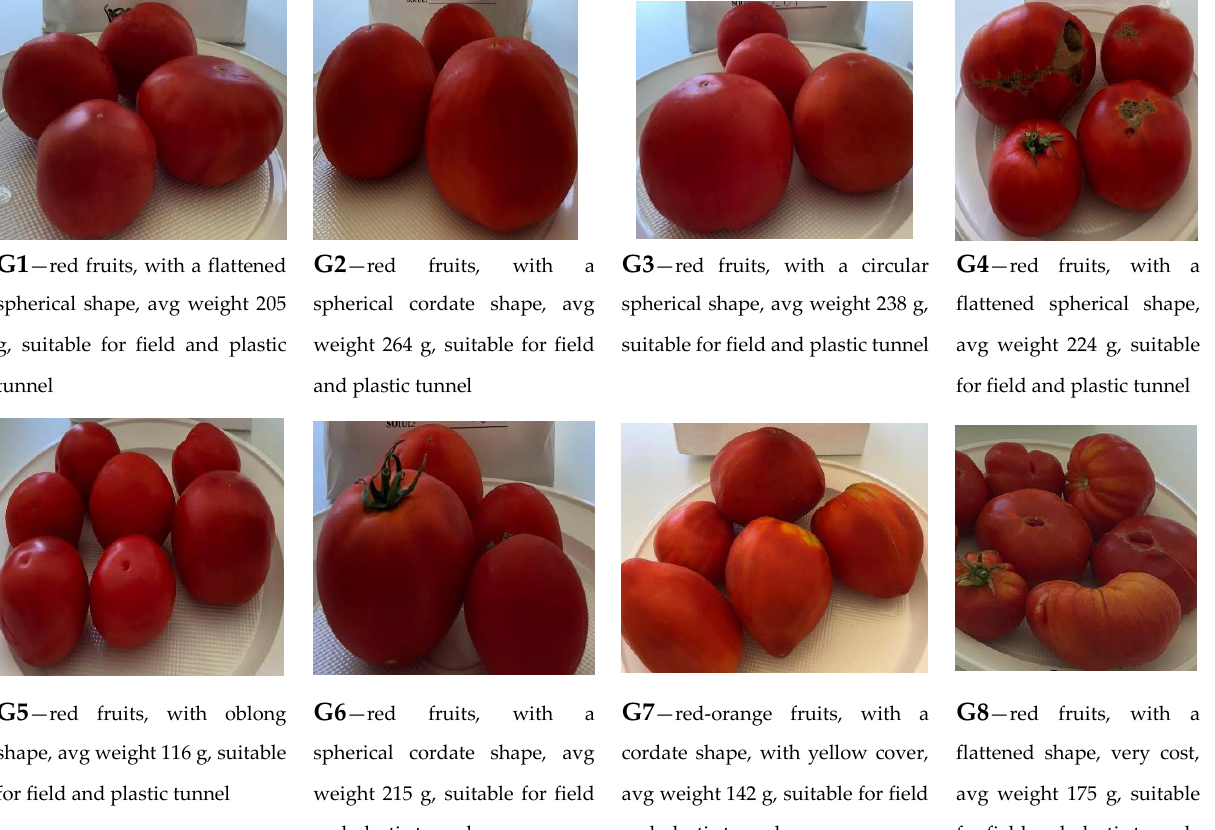
Figure 1. Sample analyzed represented by improved tomato genotypes: G1 — Genotype 1; G2 — Genotype 2; G3 — Genotype 3; G4 — Genotype 4; G5 — Genotype 5; G6 — Genotype 6; G7 — Genotype 7; G8 — Genotype 8. 3; G4 —Genotype 4; G5 —Genotype 5; G6 —Genotype 6; G7 —Genotype 7; G8 —Genotype